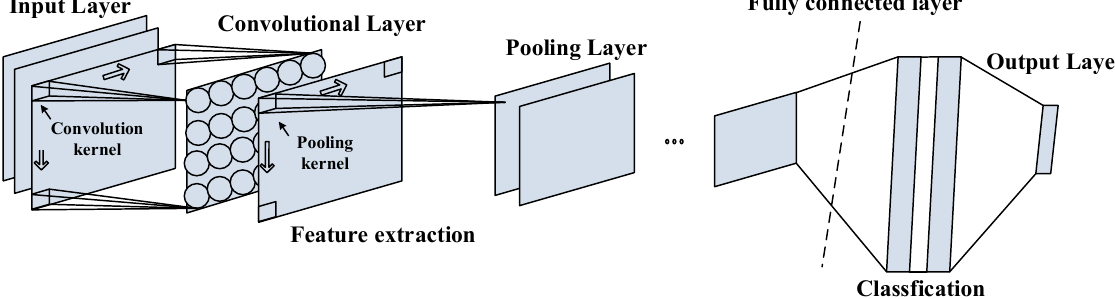
Figure 3. Convolutional Neural Network (CNN) structure.